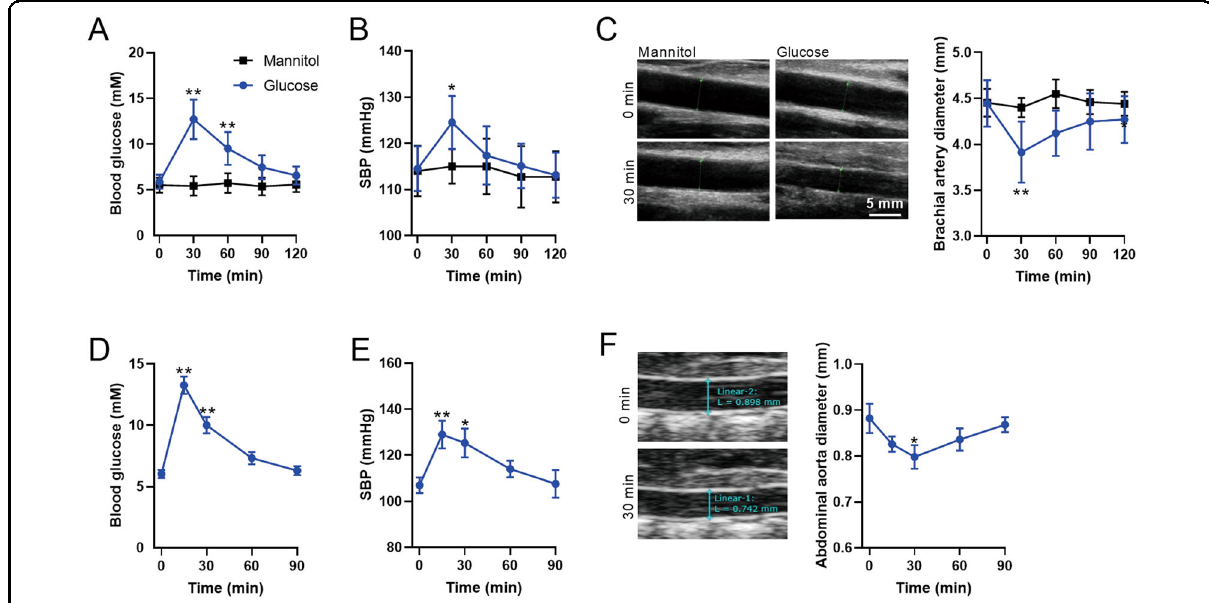
Fig. 1 Glucose challenge induced vascular constriction in humans and mice. A – F Blood glucose ( A ), systolic blood pressure (SBP) ( B ) and the maximal brachial artery diameter ( C ) in response to oral glucose challenge in humans. Representative images of the maximal diameter of brachial artery in response to glucose challenge are shown in left, and the quanti fi ed results are shown in right ( C ). n = 8 subjects. D – F Blood glucose ( D ), SBP ( E ), and the maximal abdominal aorta diameter ( F ) in response to intraperitoneal glucose challenge in mice. Representative images of the maximal abdominal aorta in response to glucose challenge are shown in left, and the quanti fi ed results are shown in right ( F ). n = 8 mice. Error bars represent SEM. * P < 0.05. ** P <